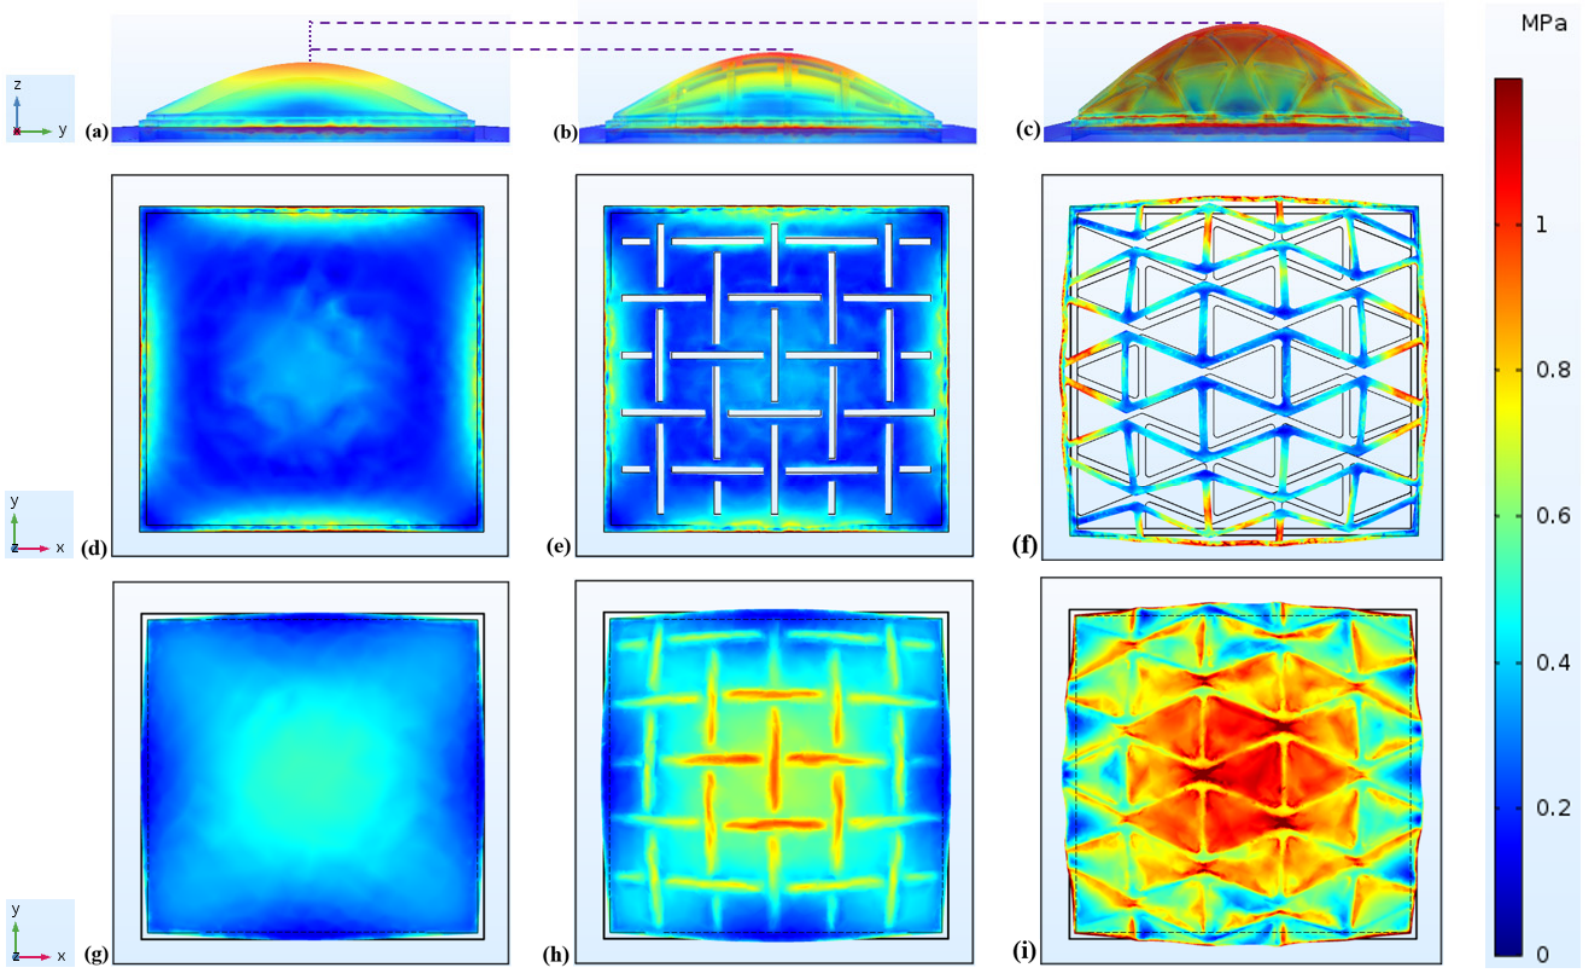
Figure 20. Each column is given to one type of sensor: CPS ( a , d , g ), kirigami MPS ( b , e , h ), and hexagonal MPS ( c , f , i ). The first row shows the displacement and stress distribution of sensors from side view ( a – c ). The second row illustrates displacement and stress distribution of membrane/MetaMems from top view ( d – f ). The third row displays displacement and stress distribution PVDF from top view ( g – i ).